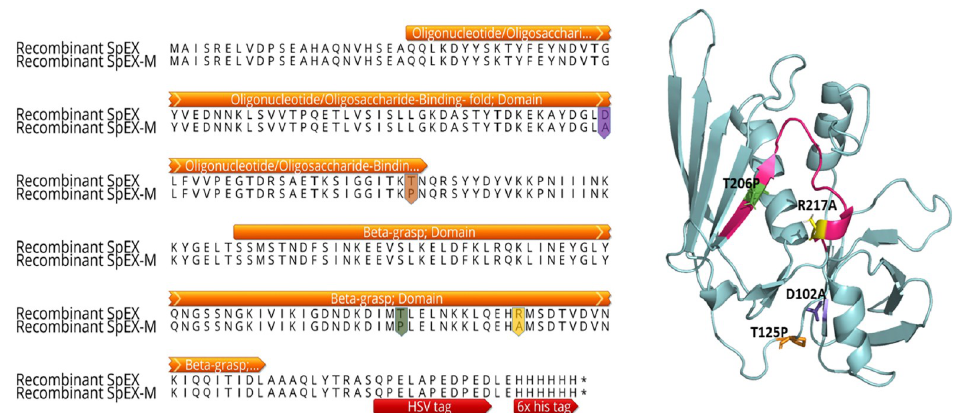
Fig 3. Residues substituted to produce attenuated S . pseudintermedius SpEX-M. Pairwise amino acid sequence alignment between recombinant SpEX and SpEX-M. Attenuated SpEX-M had substitutions of D102A and T125P (highlighted in purple and orange color, respectively) in the OB-fold domain and T206P and R217A (highlighted in green and yellow color, respectively) in the sialated glycan binding domain. The herpes simplex virus (HSV) tag and 6x his tag were annotated with red arrows whereas the protein domains were annotated with orange arrows.